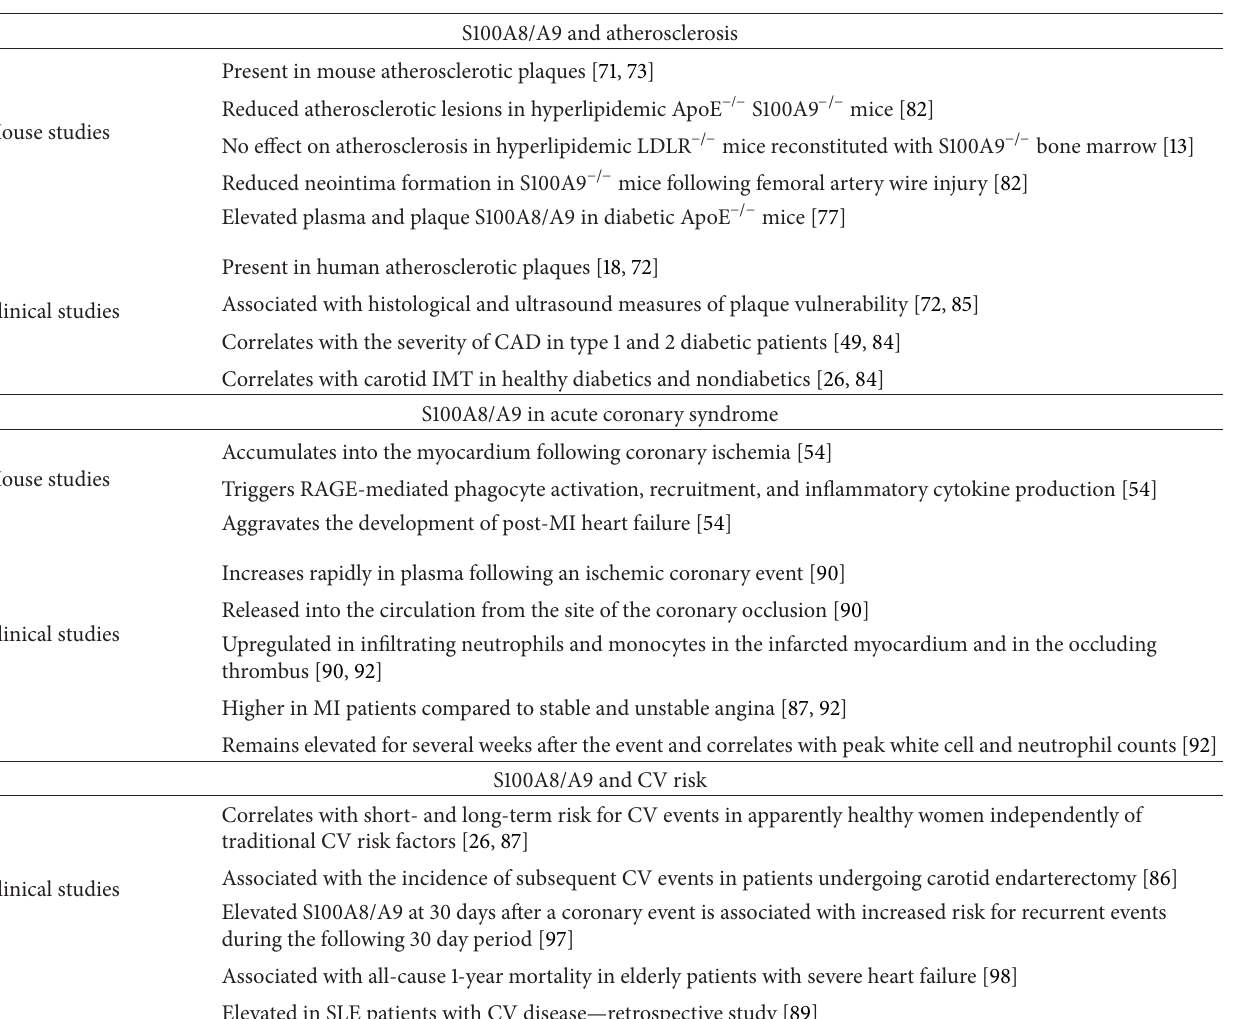
Table 1: S100A8/A9 in cardiovascular